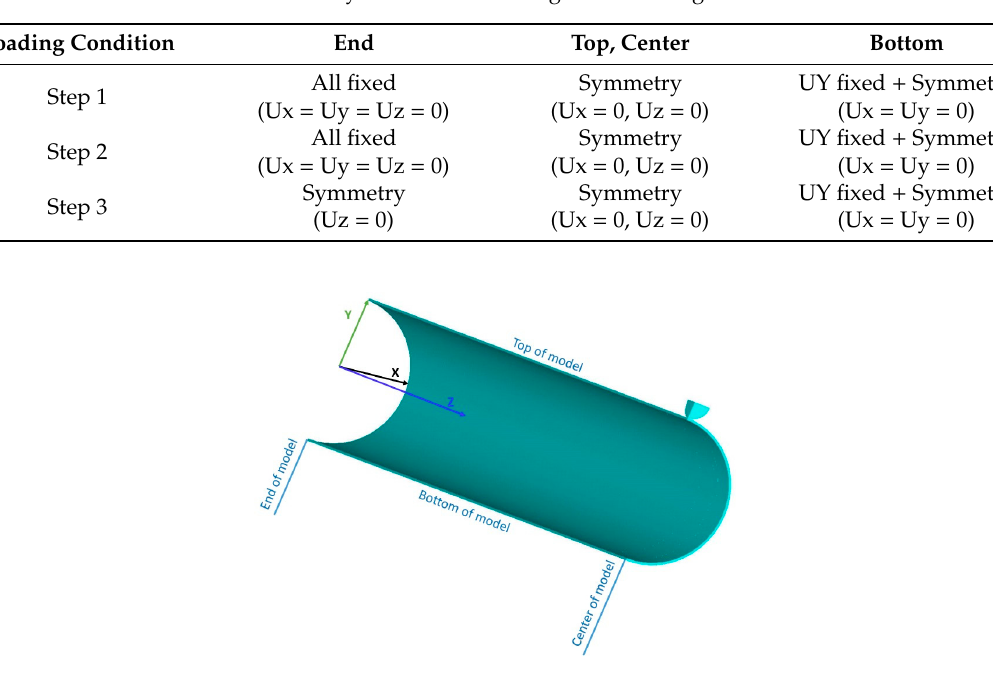
Table 2. Boundary condition according to the loading condition.